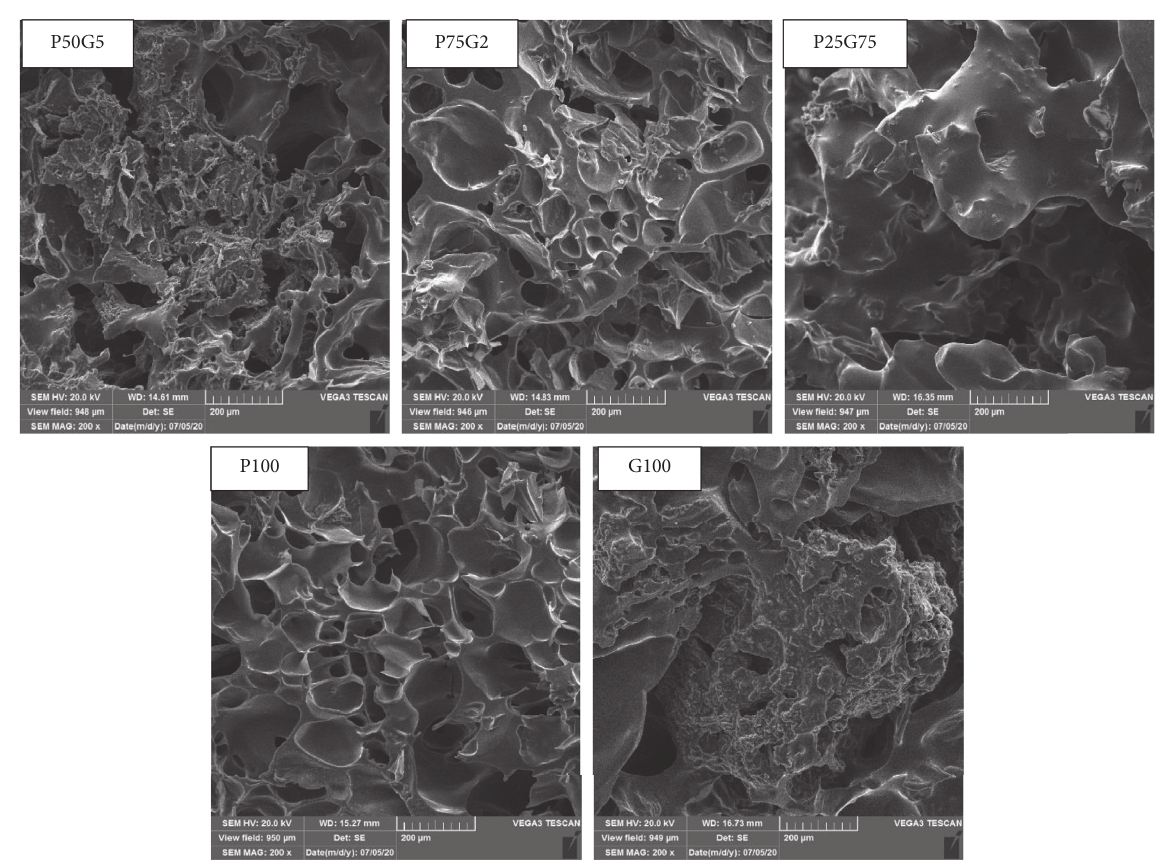
Figure 3: The effects of pectin: gum ratio on the microstructure of samples. Table 5: The effects of pectin: gum ratio on the sensorial properties of